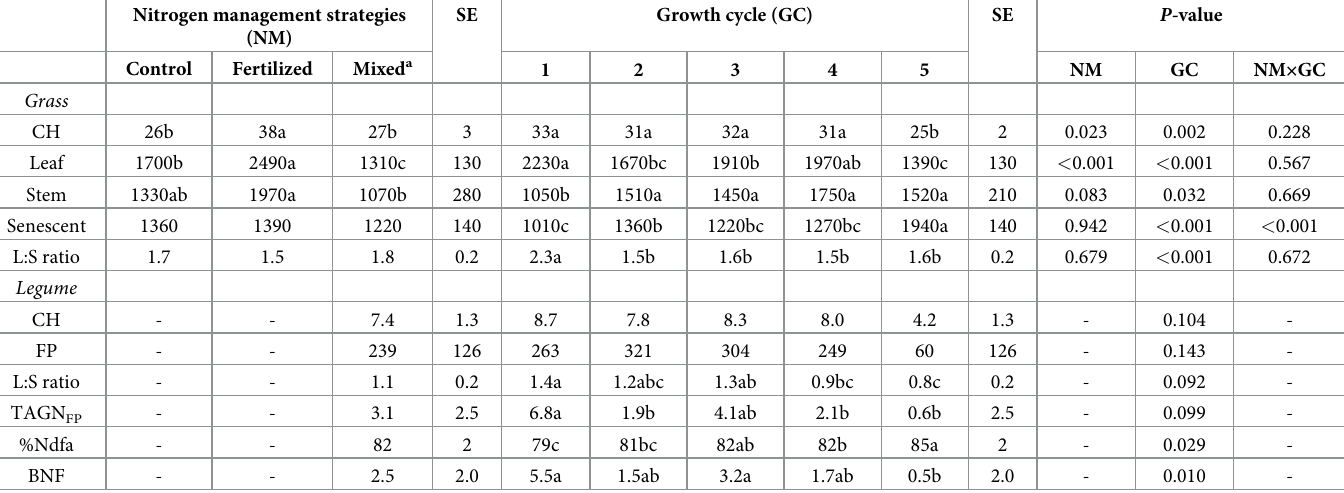
a Mixed treatment was separated into palisadegrass and forage peanut data.